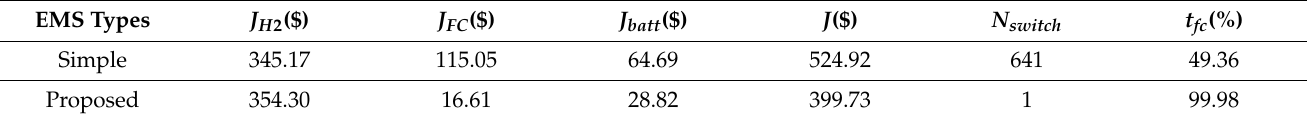
Table 6. Trip costs of the simple EMS and the proposed-based EMS for a 10-day driving